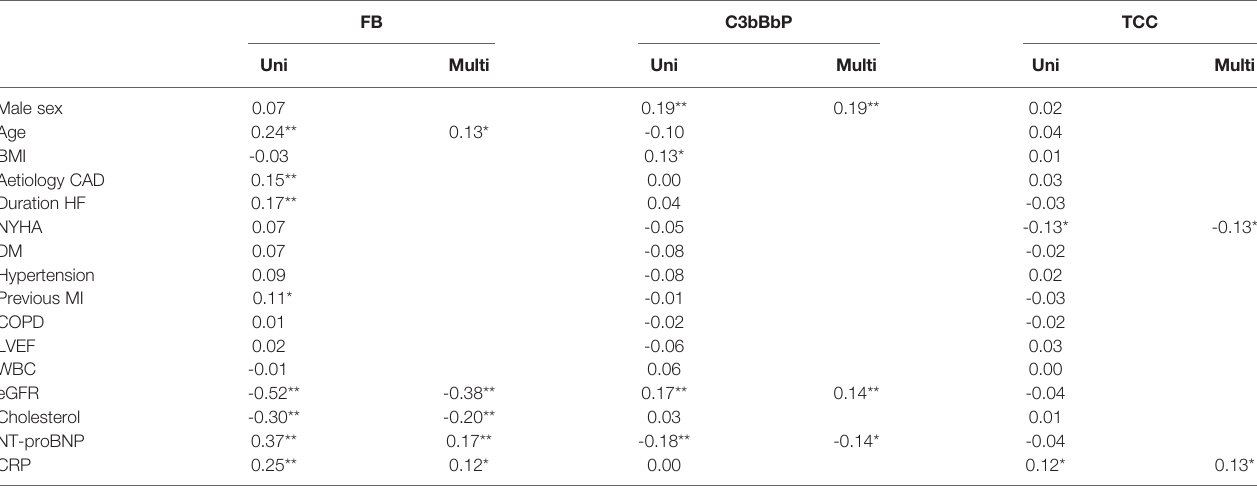
TABLE 2 | Univariate and Multivariate analysis of FB, C3bBbP and TCC.